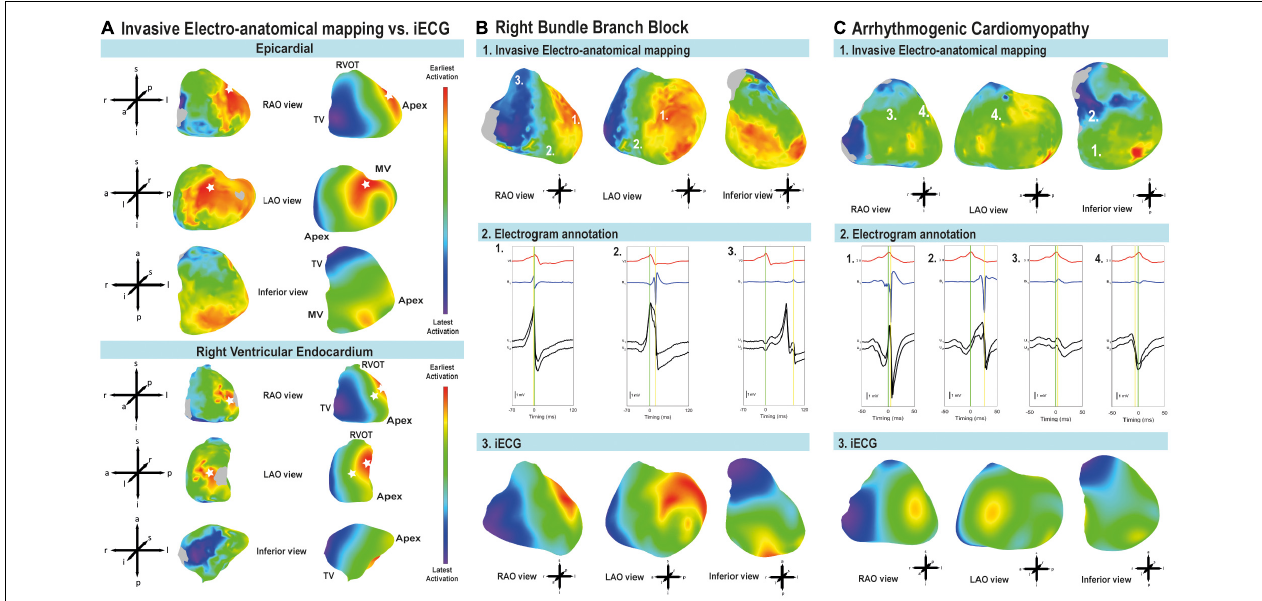
FIGURE 2 | Comparison of early and latest activated myocardium and annotation of local activation timing. (A) LAT maps derived from iECG and EAM from early (red) to late (blue) activation. Breakthroughs of ventricular activation are indicated with a white asterisk. Epicardium: both EAM and iECG estimation showed breakthrough of activation at the right ventricular free wall and the left ventricular free wall. Endocardial activation of the right ventricular free wall: iECG estimation corresponds to EAM, intraventricular septum activation was located more toward the apex in the EAM. Imaging views are based on the anatomical approach for EAM (Cosio et al., 1999). MV, mitral valve; RVOT, right ventricular outflow tract; TV, tricuspid valve. (B) Patient with healed myocarditis and right bundle branch block. Imaging views are based on the anatomical approach for EAM (Cosio et al., 1999). 1: Epicardial EAM-LAT map from early (red) to late (blue) activation. The early regions in the left ventricle and late regions in the right ventricle suggest a right bundle branch block. 2: EGM annotation of bipolar electrograms. The green line corresponds to the timing reference. The yellow line shows annotation to the maximal amplitude of the bipolar signal. 3: i ECG-LAT map of epicardial activation from early (red) to late (blue) activation. (C) Epicardial activation and electrogram annotation in a patient with arrhythmogenic cardiomyopathy. Imaging views are based on the anatomical approach for EAM (Cosio et al., 1999). 1: EAM-LAT maps from early (red) to latest (blue) activation. 2: Electrogram annotation of bipolar signals. The green line corresponds to the timing reference. The yellow line shows annotation to the maximal amplitude of the bipolar signal. 3: i ECG-LAT map from early (red) to late (blue)